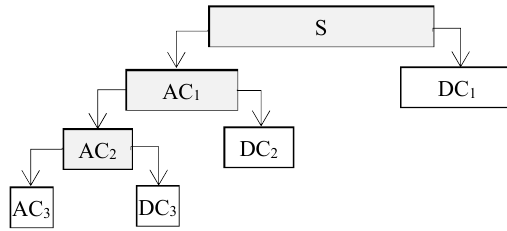
Figure 1. Process of multi-level discrete wavelet transform decomposition of signal S. AC i and DC i denote the approximation coefficient (AC) and detail coefficient (DC) at the i th decomposition level (L i ). Taking L 3 for example, the output wavelet decomposition vectors include AC 3 , DC 1 , DC 2 and DC 3 . The size of each box demonstrates the length of the successive approximation and detail coefficients vectors.